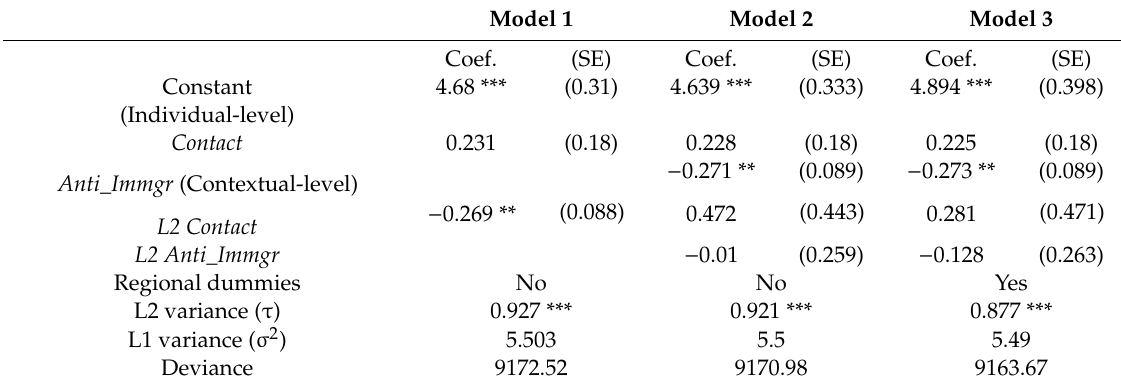
Table 4. Multilevel Linear Regression Estimates from Predicting Generalized